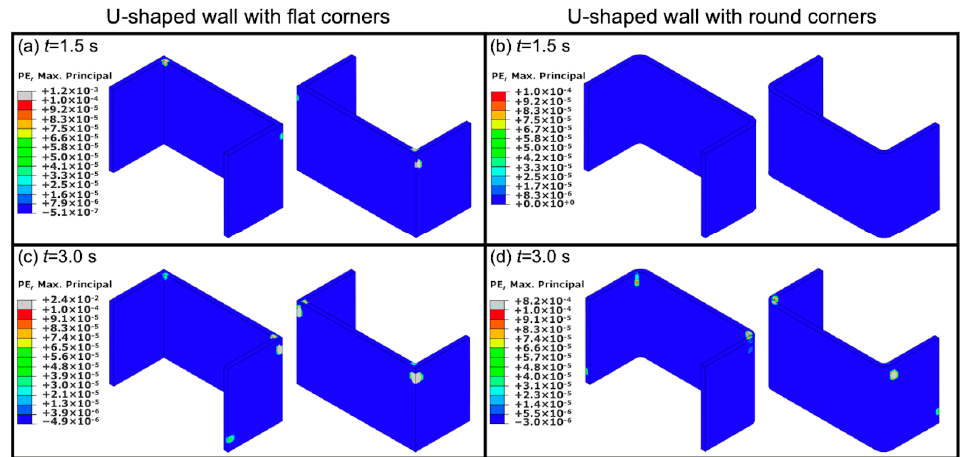
Figure 13. Contour plots of the maximum principal plastic strain at different times of the shaking table test for U-shaped walls with flat corners and round corners: ( a , b ) t = 1.5 s and ( c , d ) t = 3.0 s.